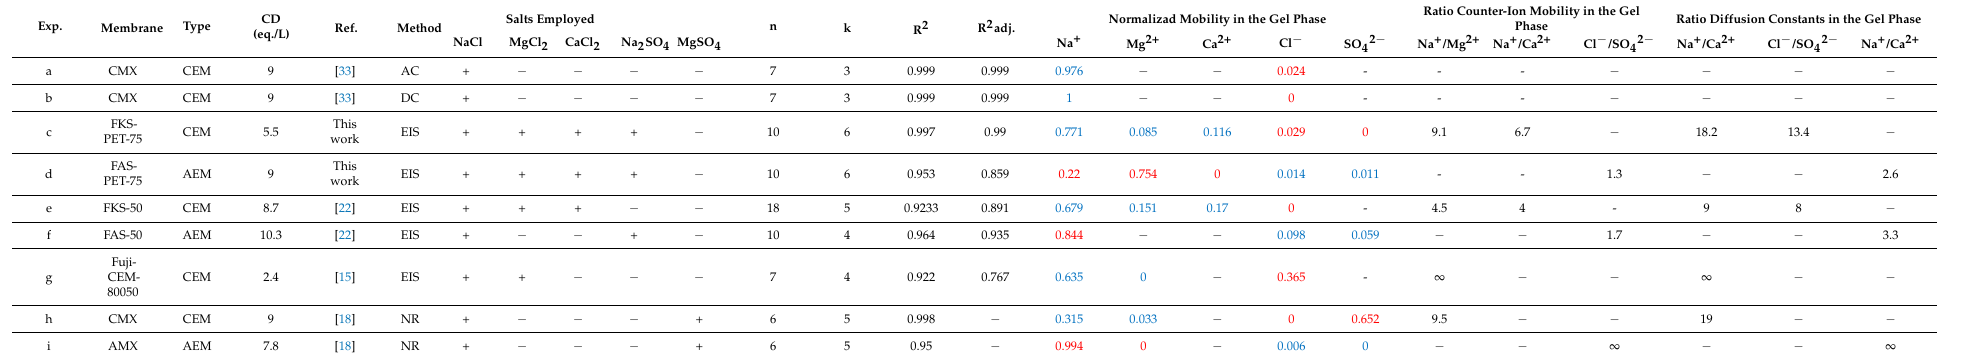
Table 3. Results of the fitting procedure. Values of the normalized mobility of counter-ions in the gel phase of the membrane are shown in blue. Values of co-ions (in red) are less reliable. Also listed are the charge density (CD), the number of data points (n), and the number of adjustable parameters. R 2 is the coefficient of determination and R 2 adj is the adjusted coefficient of determination. N.R. = not reported. Also shown are the ratios of the mobilities of mono- and di-valent ions in the gel phase and the ratios of the concerning gel diffusion